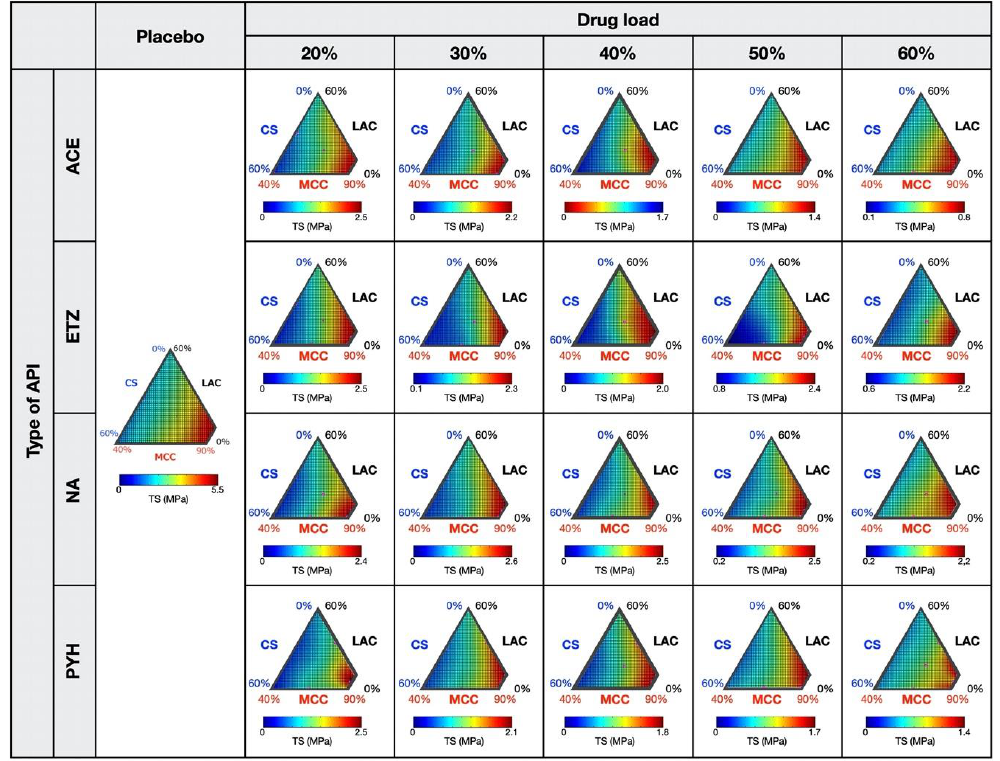
Figure 2. The response surface generated by multivariate spline interpolation (RSM-S) for the tensile strength (TS) of each tablet. The response surface of the placebo tablet is taken from our previous study [22].